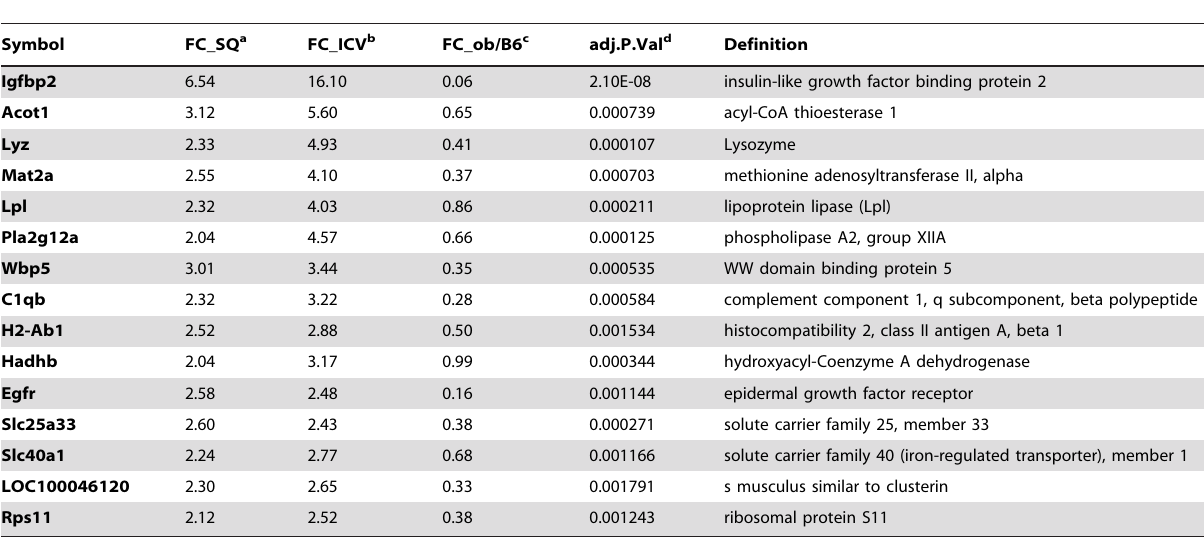
Table 1. Top 15 upregulated genes involved in leptin mediated weight